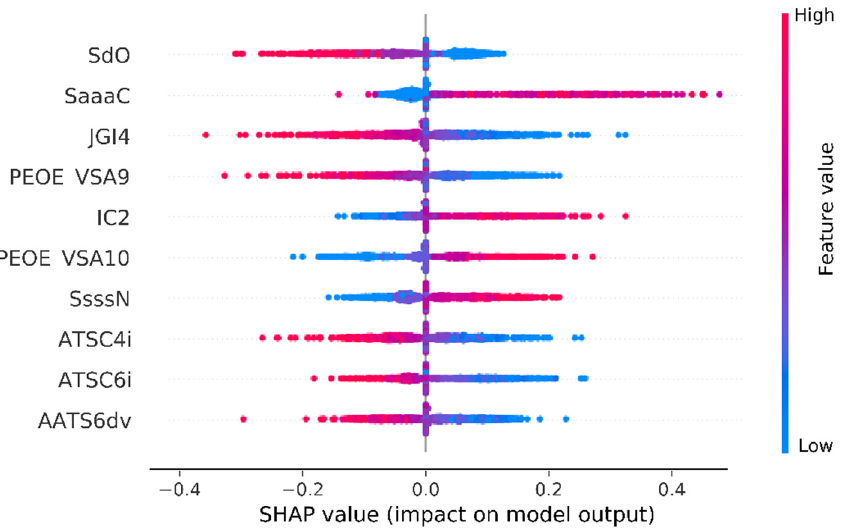
Figure 11. Aggregated feature plot ordered according to the mean absolute SHAP values. SdO— sum of dO; SaaaC—sum of aaaC; JGI4—four-ordered mean topological charge; PEOE VSA9—MOE charge VSA descriptor 9; IC2—two-ordered neighborhood information content; PEOE VSA10— MOE charge VSA descriptor 10; SsssN—sum of sssN; ATSC4i—centered Moreau–Broto autocorrelation of lag 4 weighted by ionization potential; ATSC6i—centered Moreau–Broto autocorrelation of lag 6 weighted by ionization potential; AATS6dv—averaged Moreau–Broto autocorrelation of lag 6 weighted by valence electrons [46].